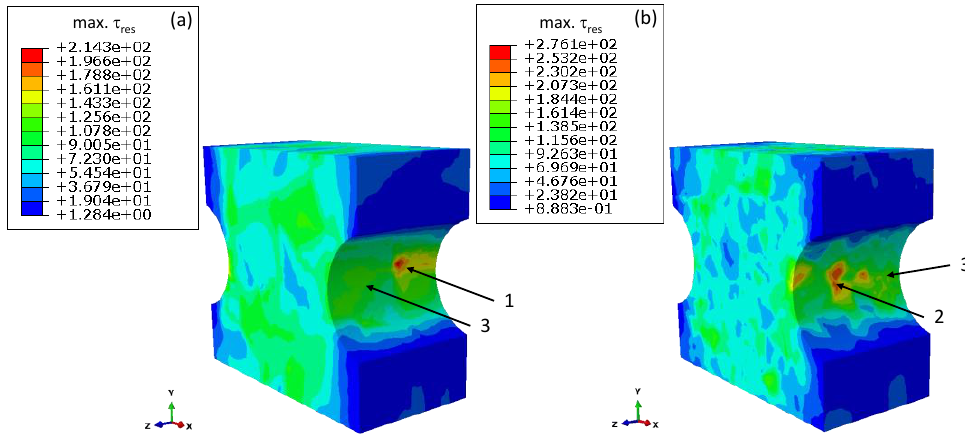
Figure 13. Distribution of the maximum shear stress within the slip system of the grains for the coarse-grain material (100 grains, ( a )) and fine-grained textured material (1000 grains, ( b )).